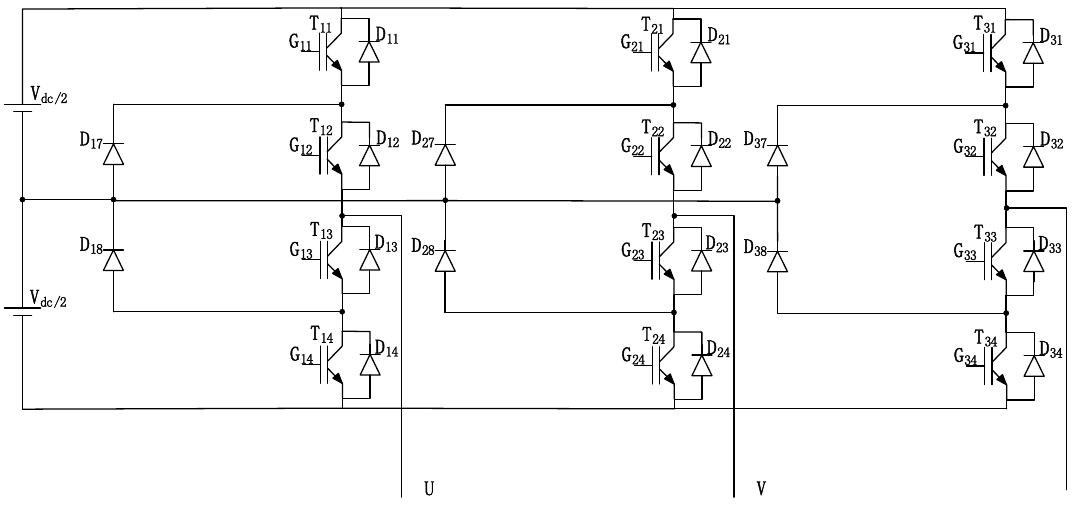
Figure 1. Traditional D-NPC (diode neutral-point-clamped) topology.